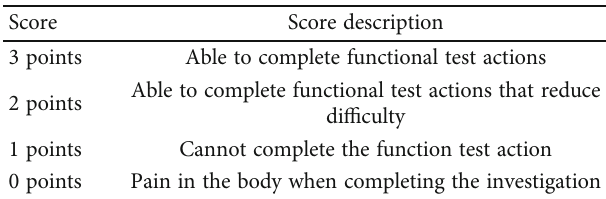
Figure 5: Ultrasound image and vector image overlay image. Table 1: FMS test score description